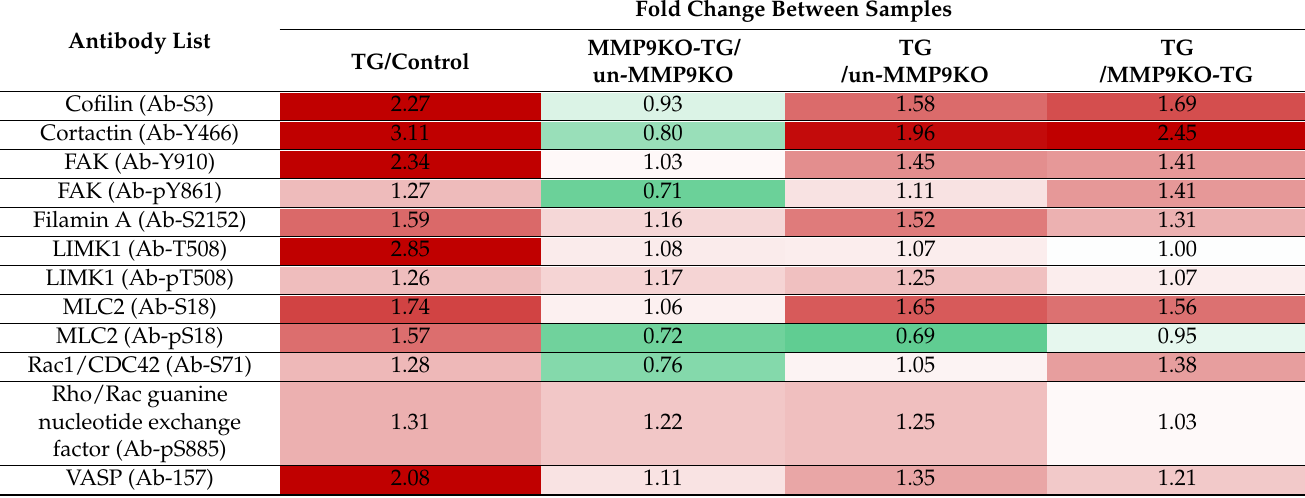
Table 1. Table showing fold changes of cytoskeletal protein expression. Cytoskeletal protein array analysis was conducted using untreated wildtype (control), wildtype treated with 500 pg/mL TGF- β for 72 h (TG), untreated MMP9KO (un- MMP9KO) and MMP9KO treated with 500 pg/mL TGF- β for 72 h (MMP9KO-TG) mouse LECs ( n = 3 independent experiments, where 10 µ g of protein per treatment was used for each experiment). Red represents upregulation, green represents downregulation and white indicates that no notable difference was observed between the two compared treatment groups. A darker shade of the color of the box indicates a greater fold difference between the two compared treatment